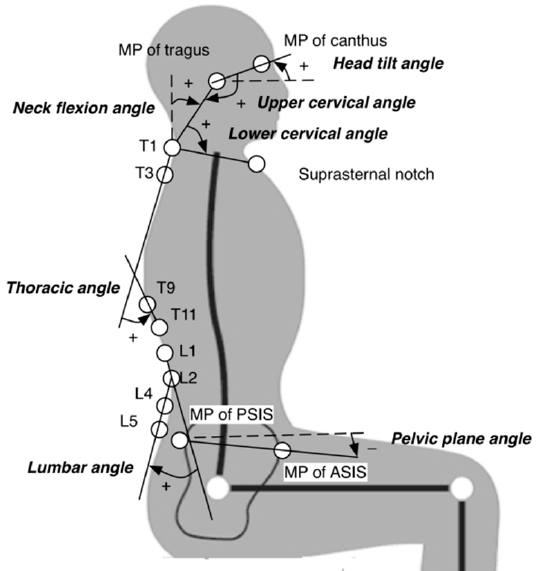
Figure 2. Placement of reflective markers and angle definitions. Decreasing head tilt, upper cervical, and lower cervical angles indicate flexion. Decreasing neck flexion, thoracic, and lumbar angles indicate extension. A negative pelvic plane angle indicates an anterior tilt of the pelvis. MP: midpoint; ASIS: anterior superior iliac spine; PSIS: posterior superior iliac supine.